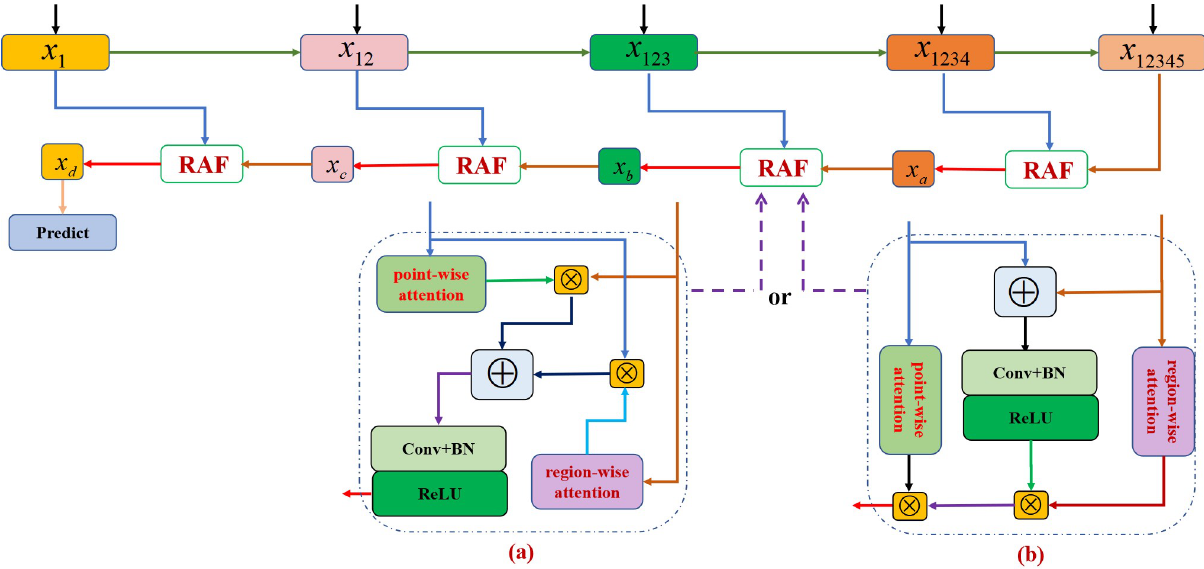
Figure 6. The illustration of the recurrent asymmetric fusion. ( a ) Recurrent asymmetric fusion based on parallel gating. ( b ) Recurrent asymmetric fusion based on hierarchical